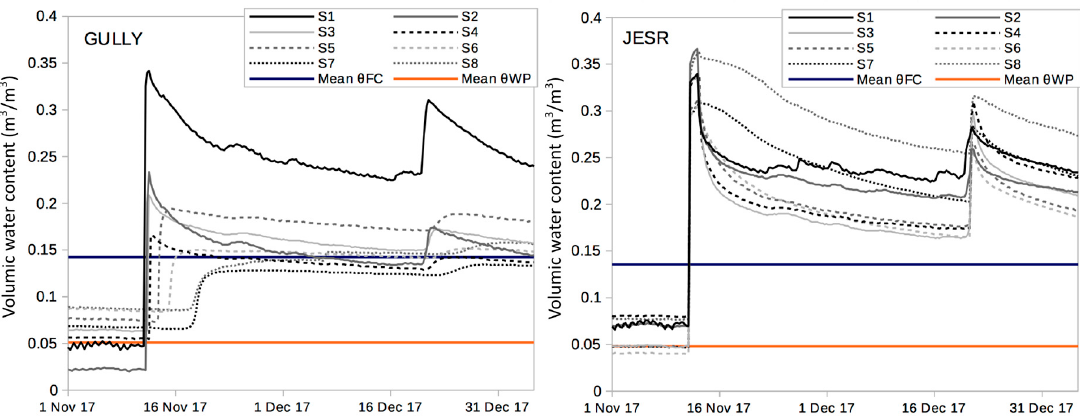
Figure 6. Evolution of soil moisture at different depths (eight sensors) in the gully and the Jesr after the 10–12 November 2017 rainfall event.